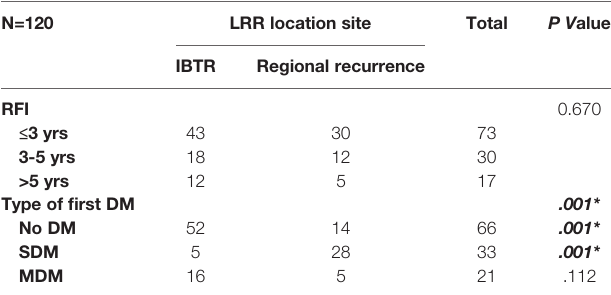
TABLE 3 | Spatiotemporal recurrence patterns across different